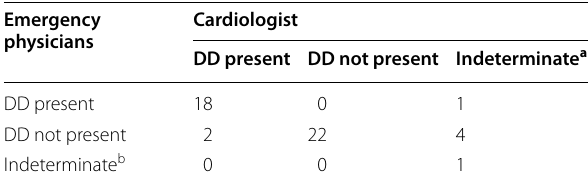
Table 1 Comparison of data utilized by emergency physician vs. cardiologist for determination of diastolic dysfunction